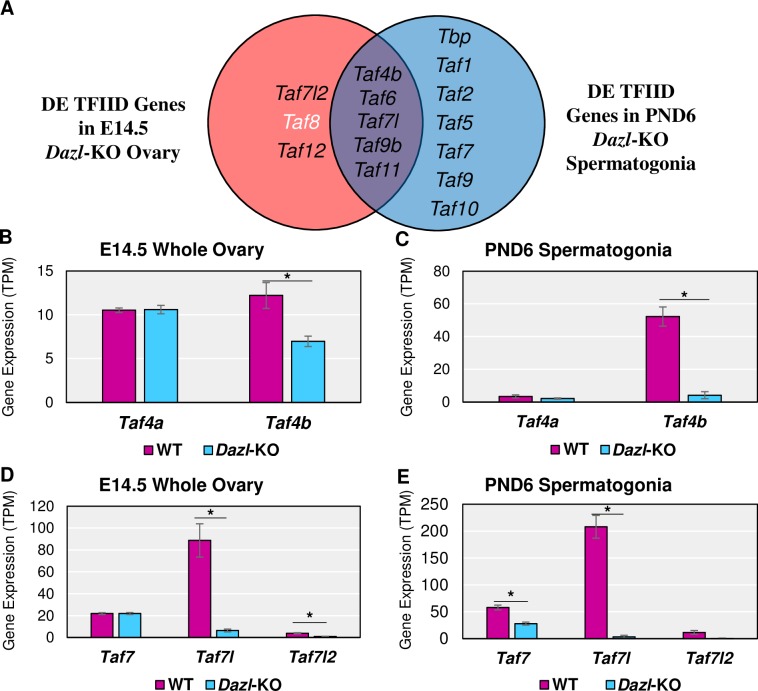
TFIID subunits in Dazl-KO female and male mice.(A) Venn diagram of TFIID subunits found to be significantly (log2FC > |0.25|, p-adj < 0.05) different between the WT and Dazl-KO of the E14.5 ovary and/or PND6 spermatogonia. Black text indicates decreased mRNA expression in the Dazl-KO and white text indicates increased mRNA expression in the Dazl-KO compared to WT. Gene expression levels of Taf4a versus Taf4b in female (B) and male (C) WT versus Dazl-KO RNA-seq experiments. Gene expression levels of Taf7, Taf7l, and Taf7l2 in female (D) and male (E) WT versus Dazl-KO experiments (* = log2FC > |0.25|, p-adj. < 0.05). Error bars indicate ± SEM.